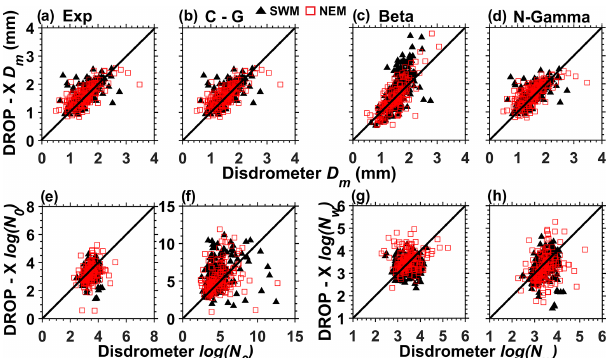
Figure 9. Scatter plots of D m obtained by the disdrometer and DROP-X with the (a) exponential, (b) constrained gamma, (c) β and (d) normalized gamma methods for the SWM (solid green tri- angle) and NEM (open red square) seasons. (e–h) Same as (a) – (d) but for log N 0 /N W